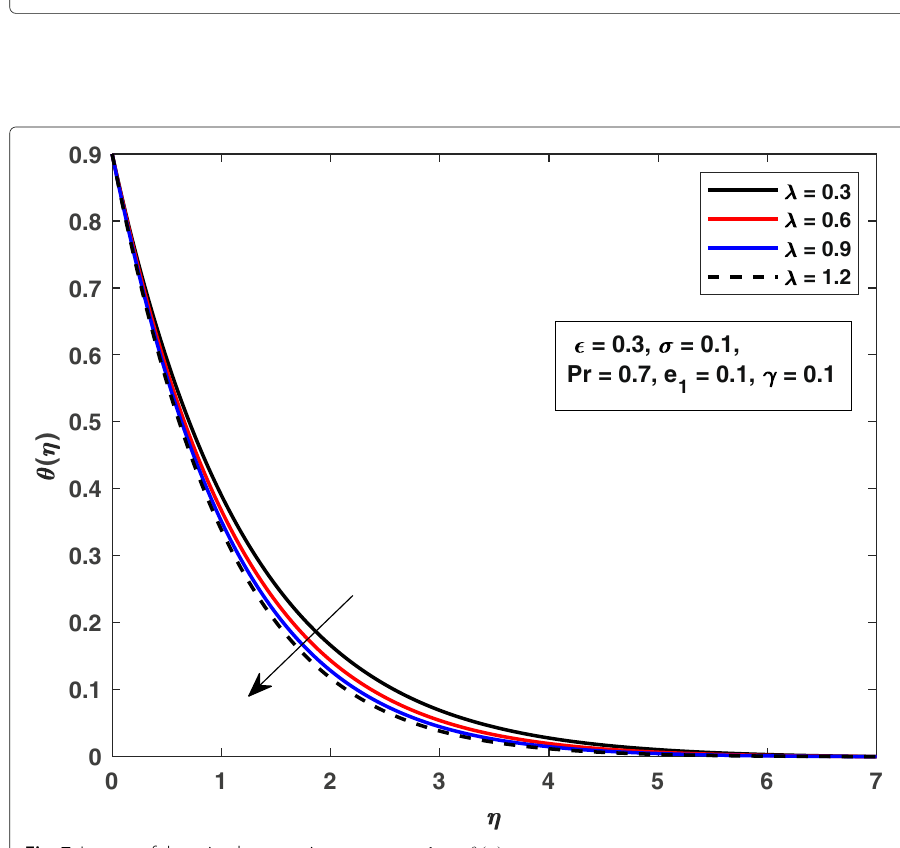
Fig. 6 Impact of the mixed convection parameter λ on f (cid:6) (η)